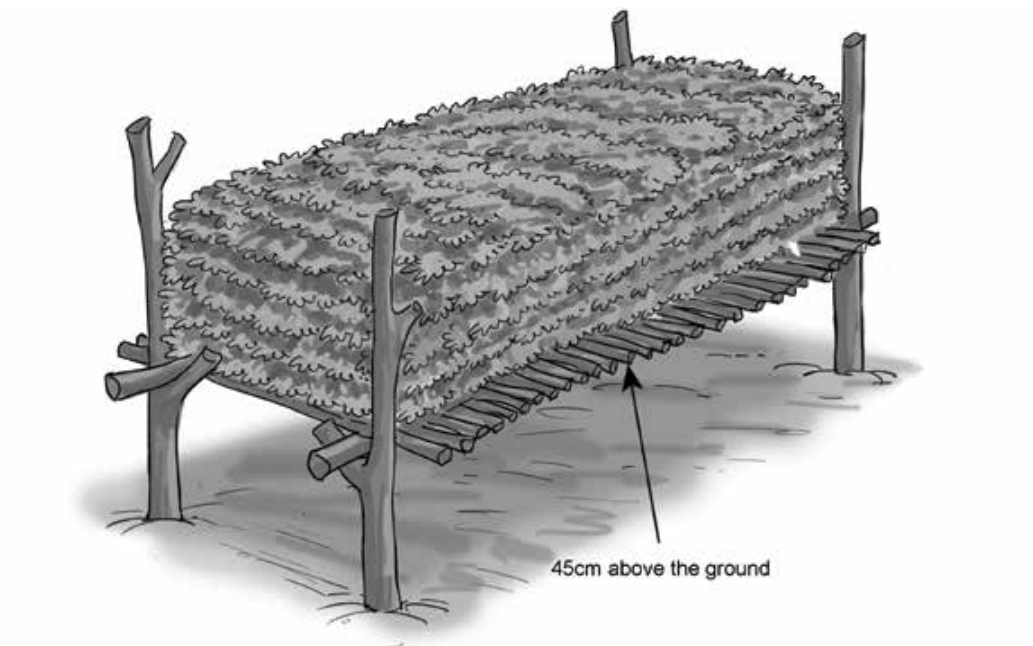
Figure 7: Wooden drying